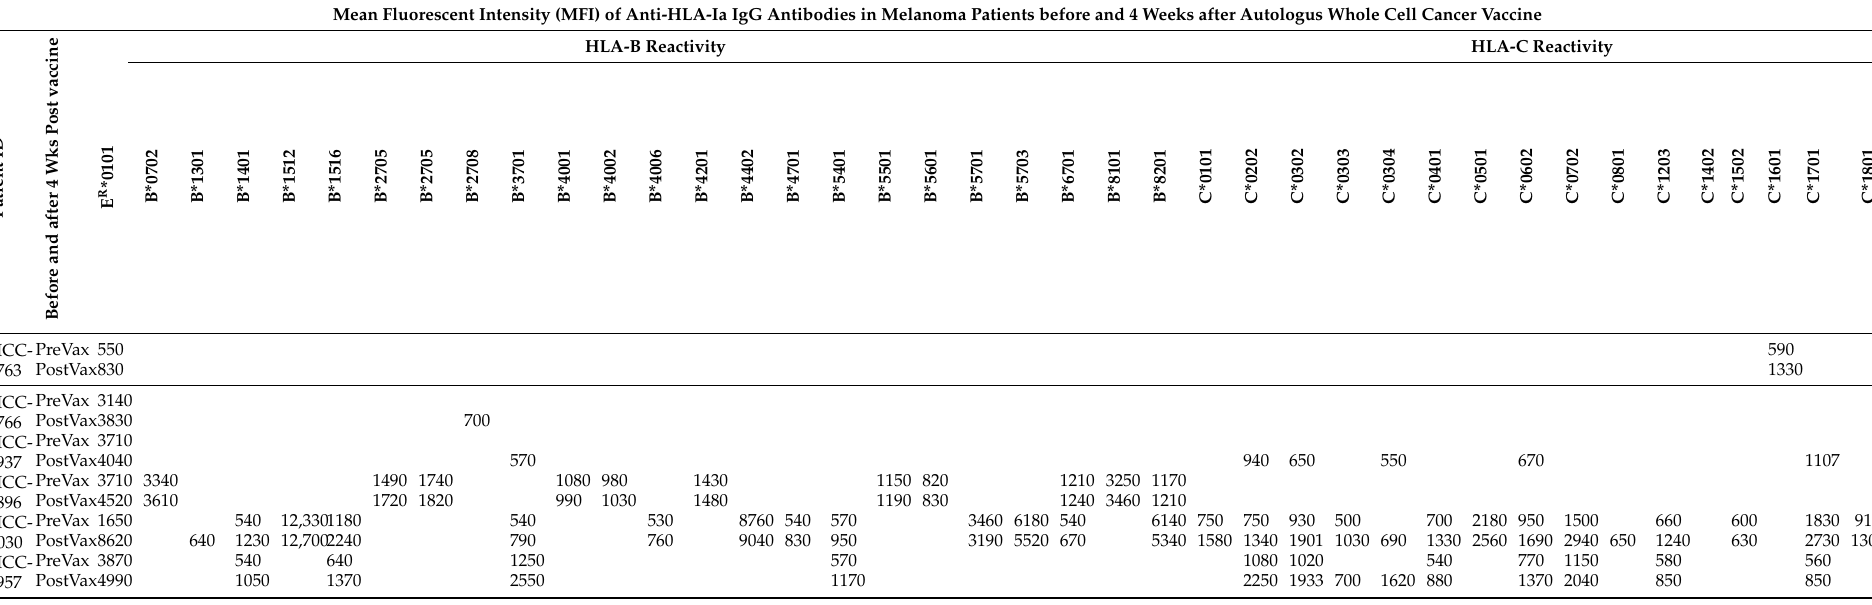
Table 12. An unaltered profile of HLA-Ia reactivity in the sera of six melanoma (Stage IV) patients before and 4 weeks after administering autologous melanoma cell vaccine (tumor cells treated with IFN γ were co-cultured with autologous dendritic cells in 1:1 ratio). Mean Fluorescent Intensity (MFI) of Anti-HLA-Ia IgG Antibodies in Melanoma Patients before and 4 Weeks after Autologus Whole Cell Cancer